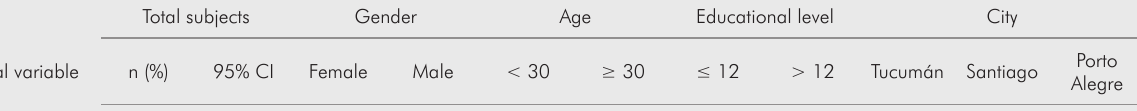
Table 3. Distribution of subjects (n and %) according to frequency of bleeding sites (GI 2+3) and frequency of visible plaque sites, for the total sample and all demographic categories.